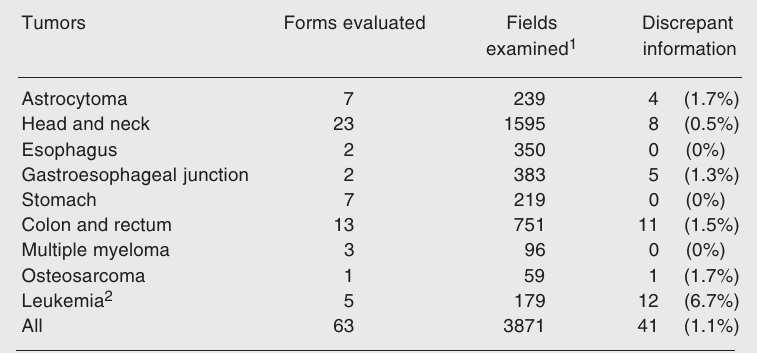
Table 3. Evaluation of data entry consistency in the clinical